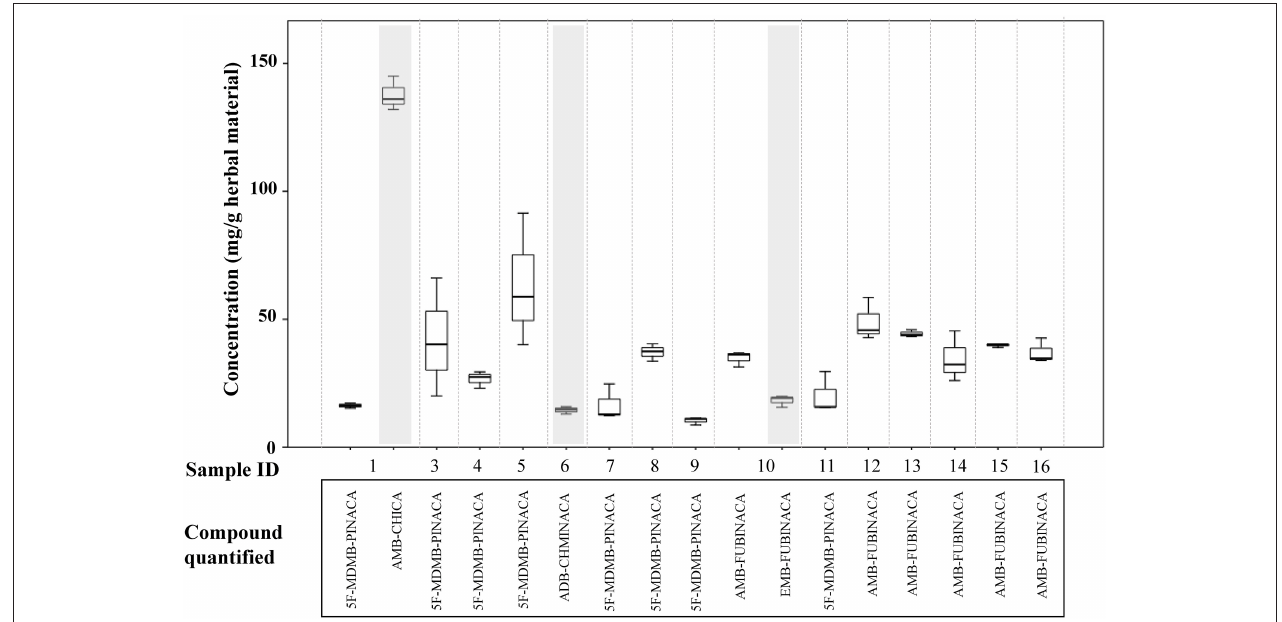
FIGURE 5 | Concentrations of synthetic cannabinoid receptor agonists (SCRAs) seized in Manchester, UK. Shaded areas denote samples where a semi-quantitative result has been calculated for a compound based on the detector response for AMB-FUBINACA.